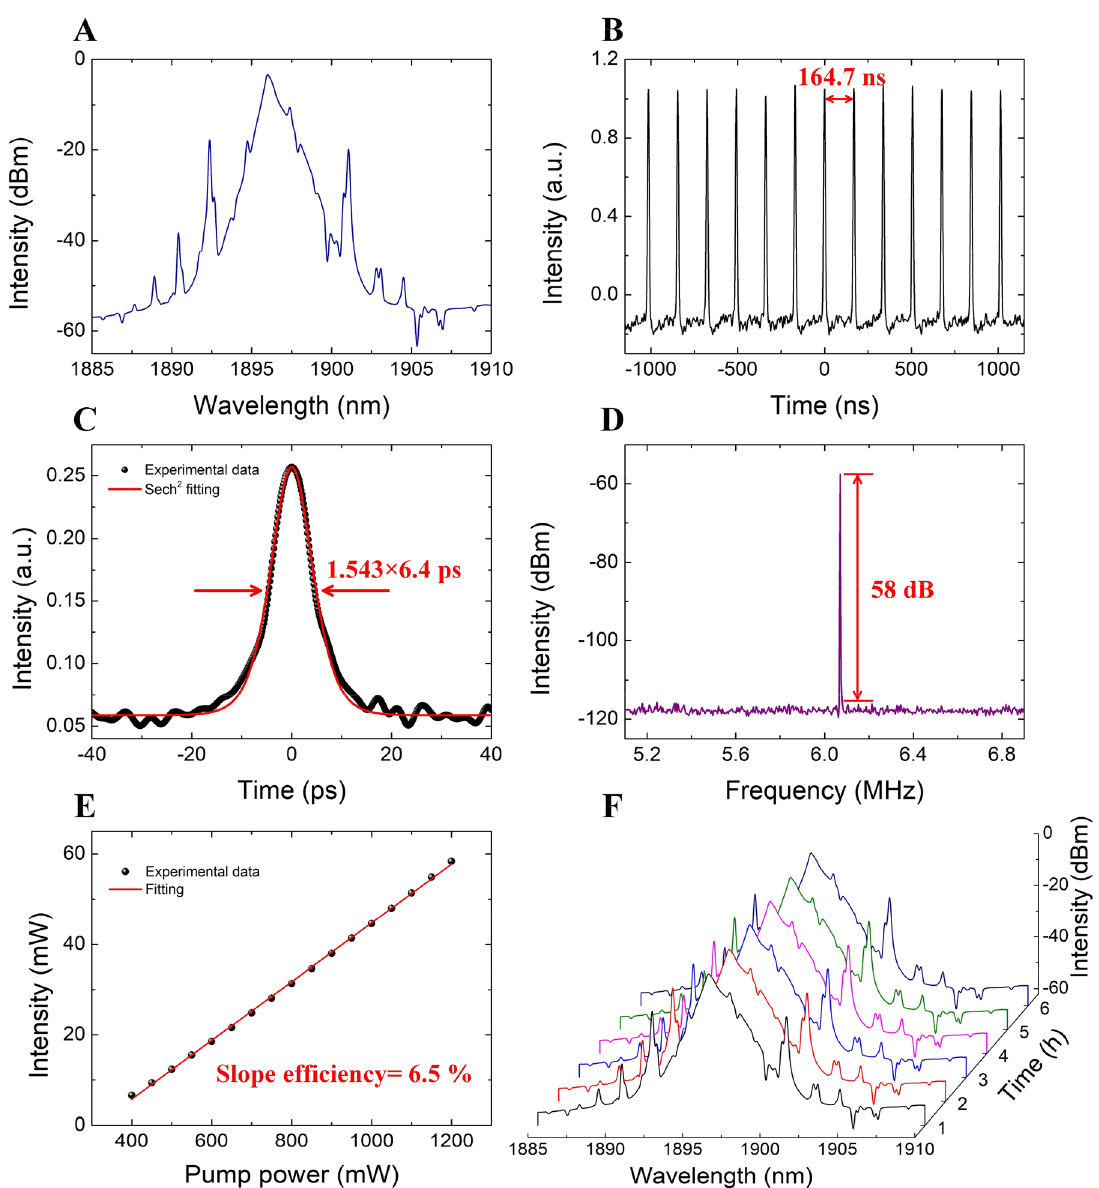
Figure 8: (A) Optical spectrum; (B) pulse trains; (C) autocorrelation trace; (D) RF spectrum; (E) relation between average output power and pump power; (F) optical spectra with different